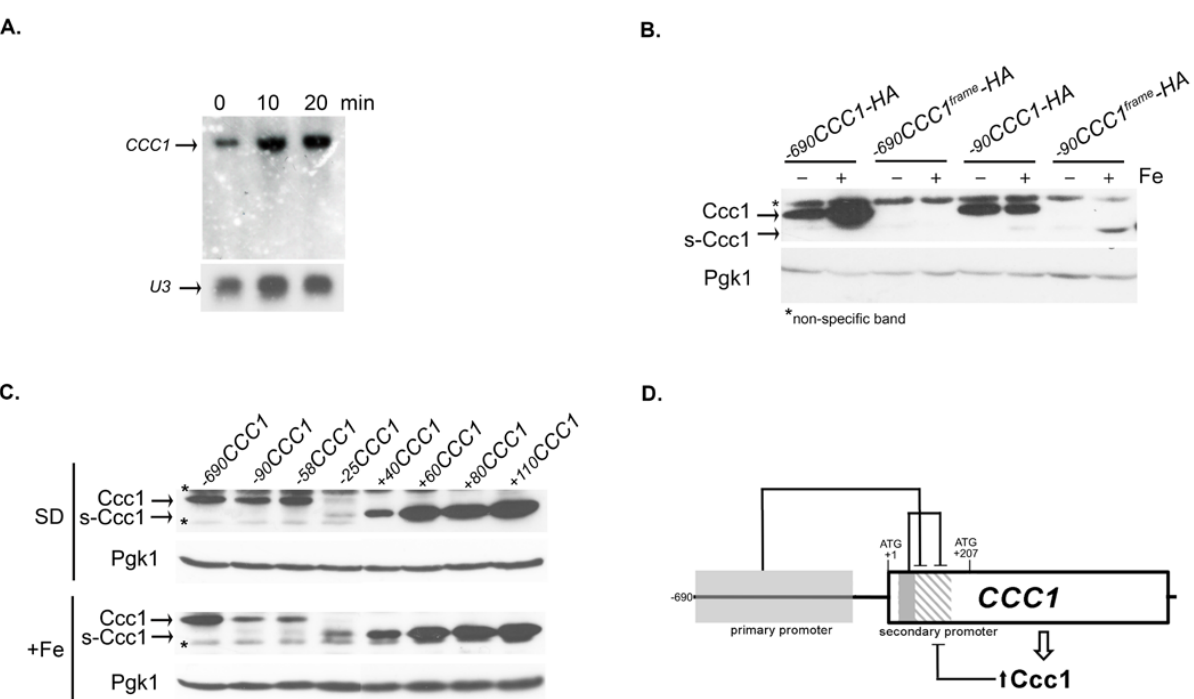
Figure 4. s-CCC1 expression is repressed in its natural genomic context. ( A ) Exponentially growing cells (wild type) were exposed to 2 mM FeSO 4 and CCC1 gene expression was analyzed by Northern blot, at the indicated time points, U3 was used as a loading control. ( B , C ) Δ ccc1 cells carrying the indicated constructs were grown to mid-exponential phase and left untreated (-SD) or treated (+) with 2 mM FeSO4, for 30 min. Protein extracts were analyzed by immunoblotting using anti-HA antibody. Pgk1 levels were used as a loading control. Asterisks indicate non-specific bands. ( D ) Schematic repre- sentation of s-CCC1 repression.